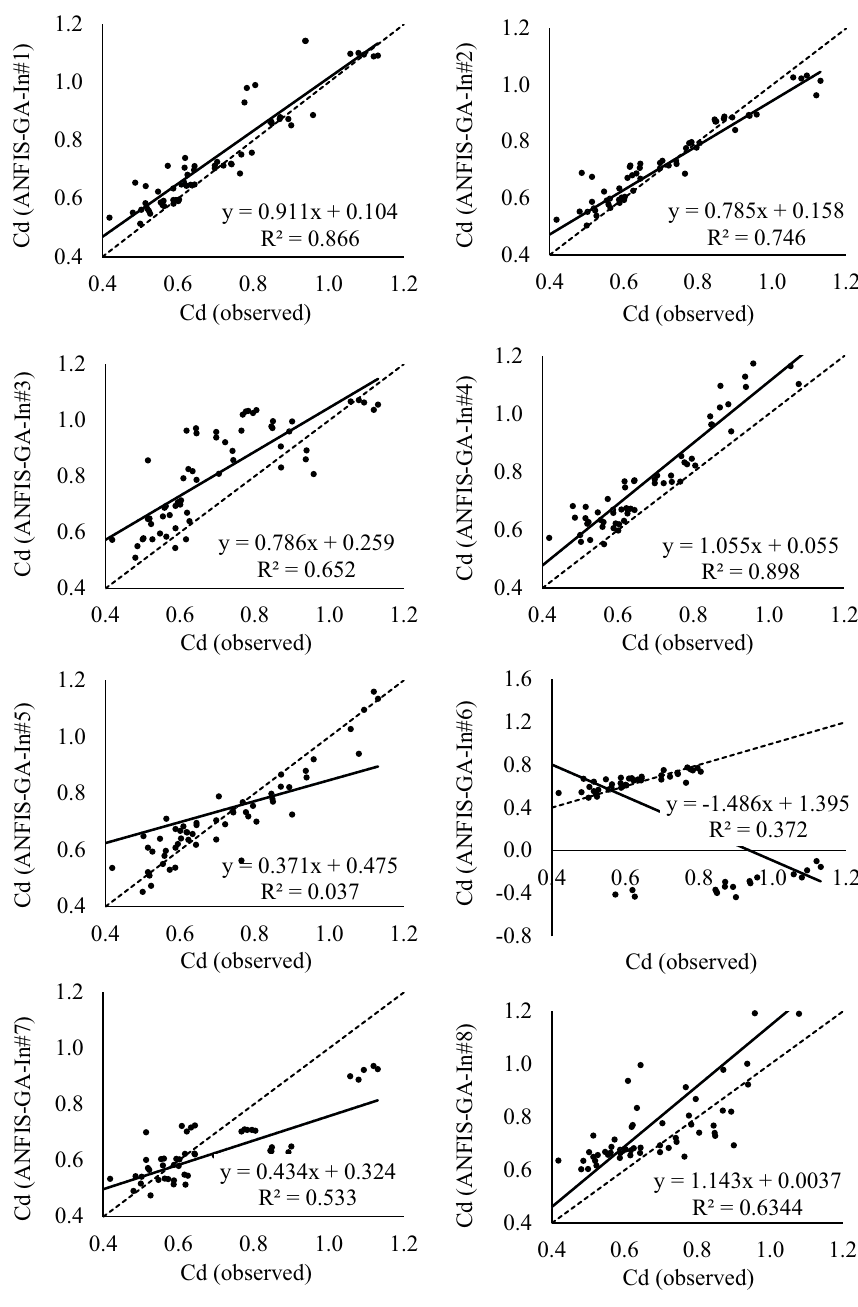
Fig. 8 Scatterplots of ANSIS- GA for various input combina- tions